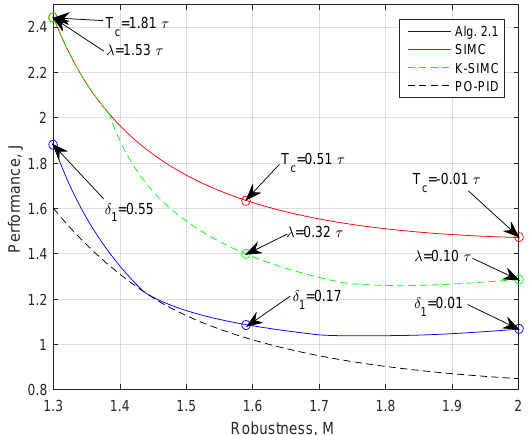
Figure 7: Example 3.4: Performance vs. robustness, J vs. M s trade-off curves. Comparing